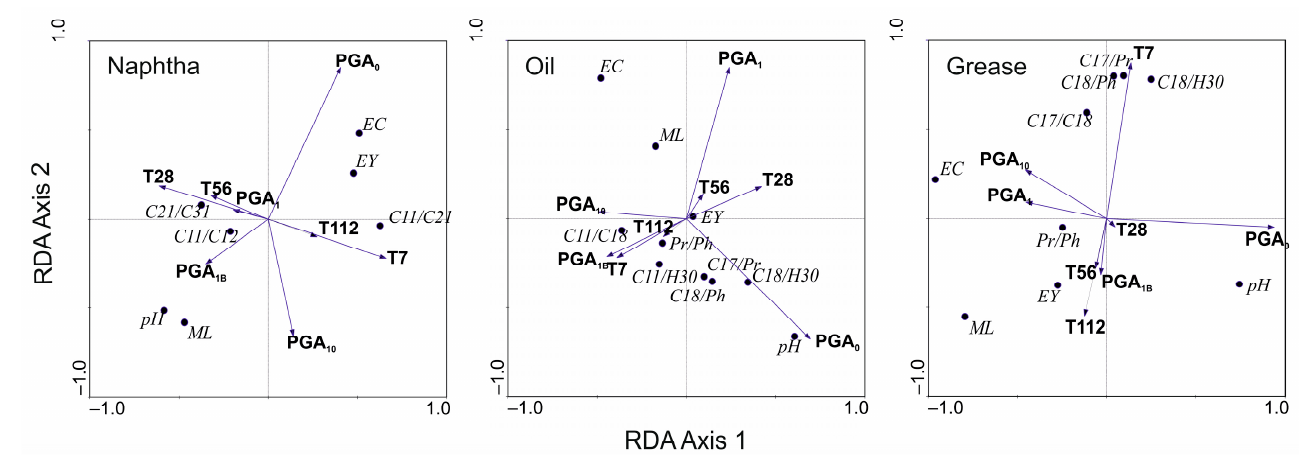
Figure 9. RDA for PGA treatments and time dummy variables and dependent variables for heavy naphtha, lubrication oil, and grease. PGA treatments: PGA 0 —reference, PGA 1 —1% PGA, PGA 1B —